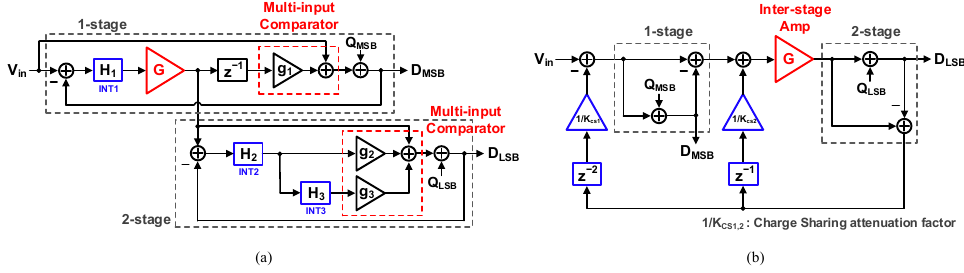
Figure 1. ( a ) Conventional CIFF structure. ( b ) Proposed EF Structure for PLNS-SAR ADC.